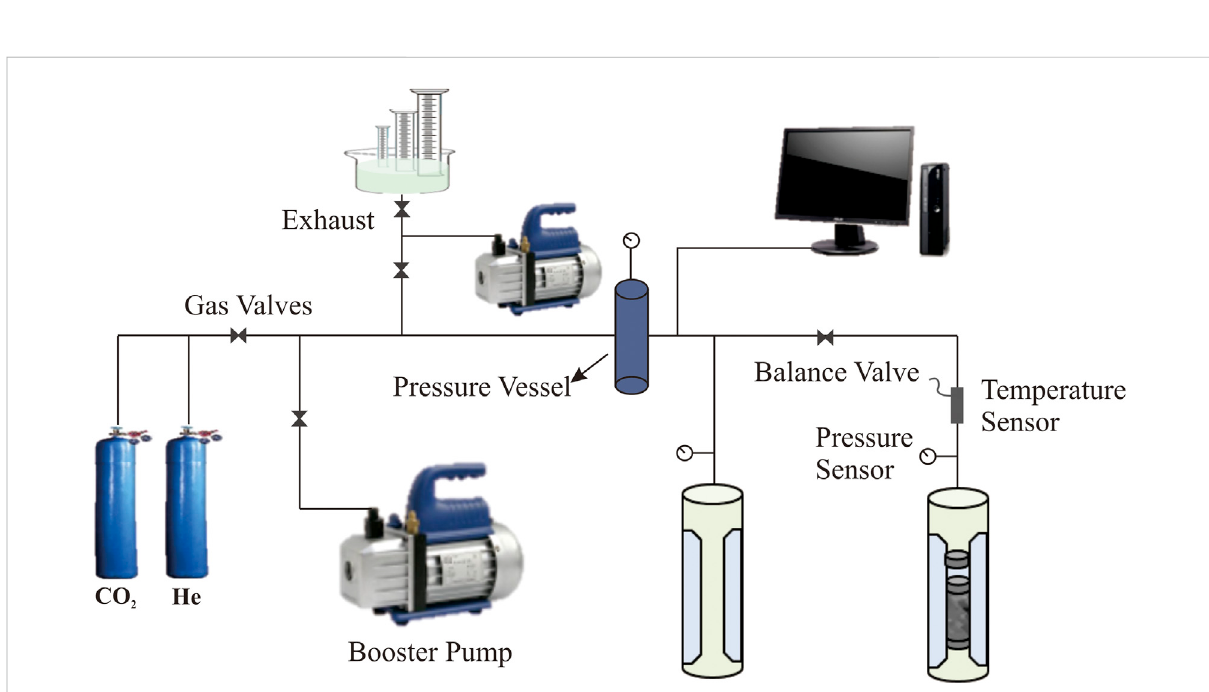
FIGURE 4 Schematic of the CO 2 adsorption isotherm